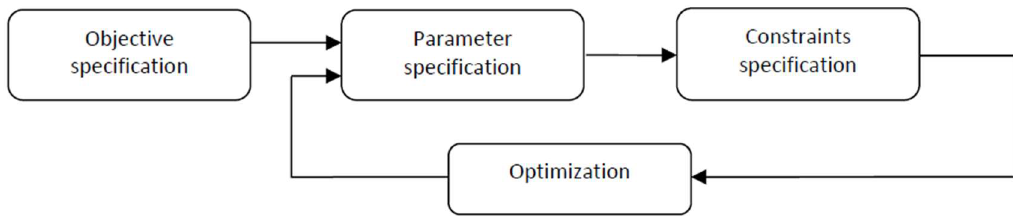
Figure 1. Steps involved in the process of optimization.